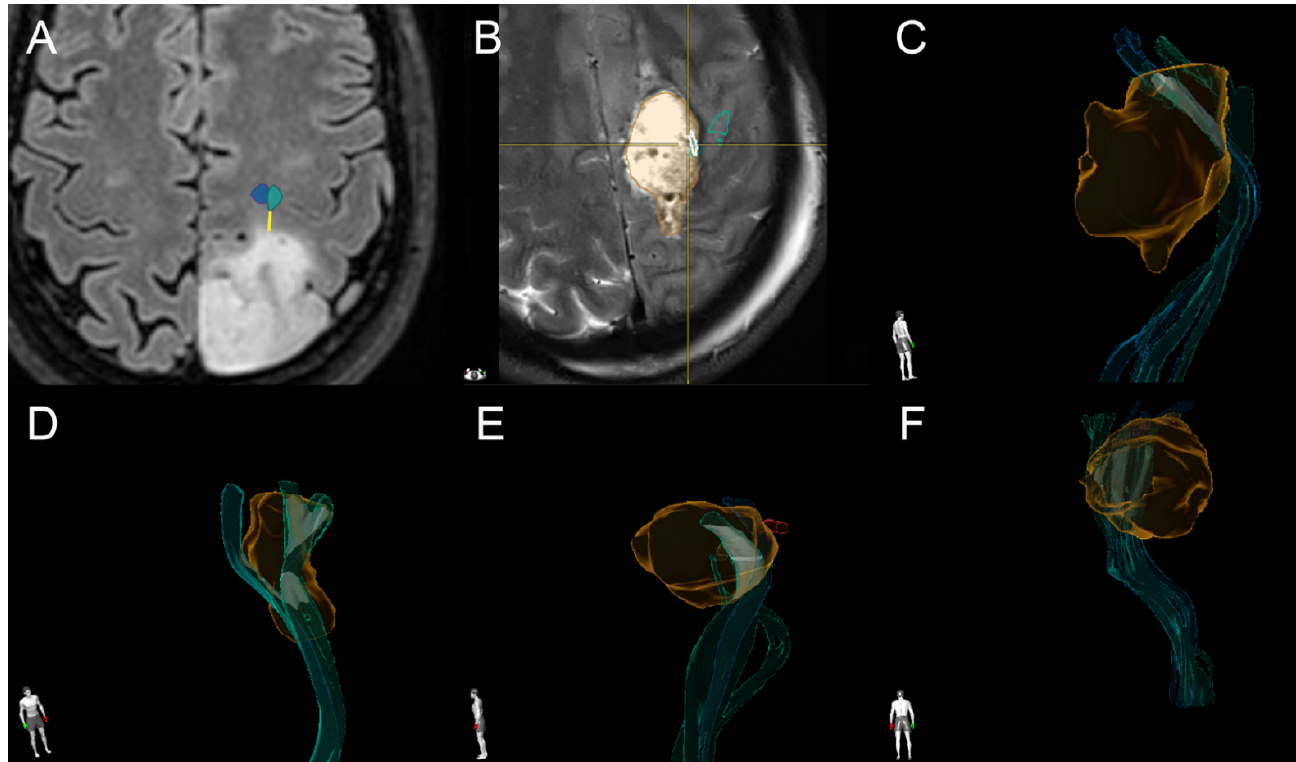
Figure 1. TTD and TRD measurement. ( A ) An example of TTD measurement (yellow line) from the hand portion of the CST (green object) in one patient from our sample; ( B ) an example of intersection (TRD = 0) of the resection cavity (orange volume) with the CST (green and light blue objects) in another patient; ( C ) a 3D reconstruction of the volume of the resection cavity and the CST in the same patient as in ( B ) (the white volume corresponds to the intersection); ( D – F ) 3D reconstructions of the volume of the resection cavity and the CST in three other patients from our sample.